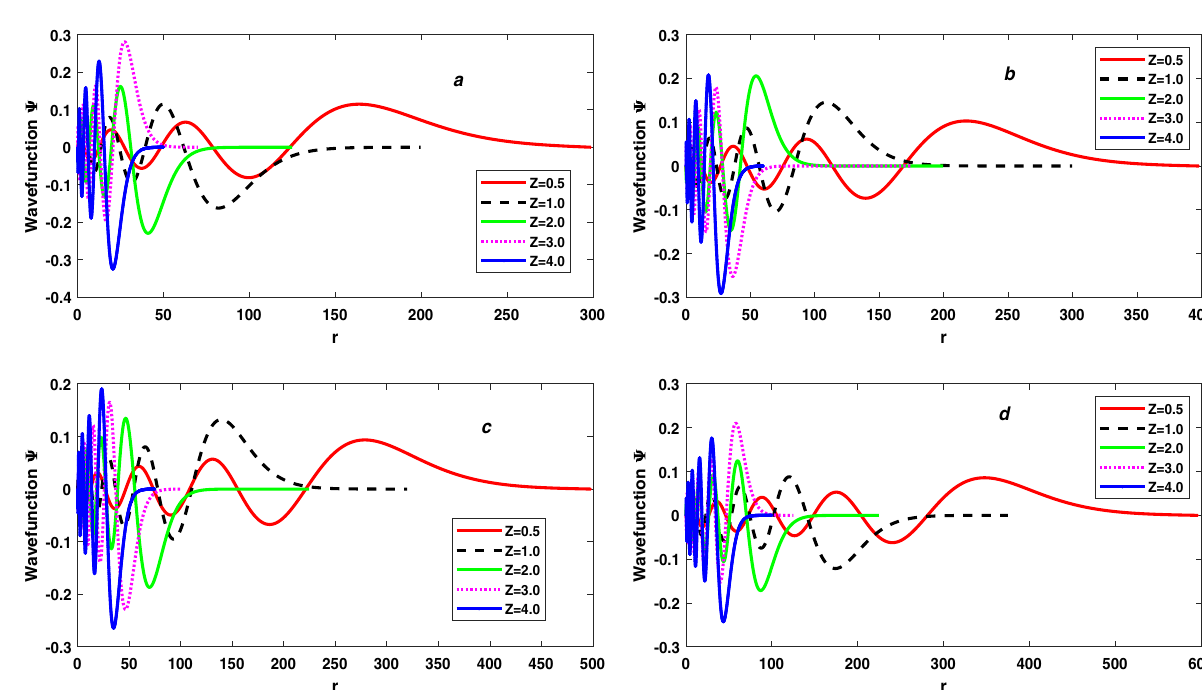
Figure 1. The variation of Wavefunction (cid:31) with r and atomic number Z for 7s state ( a ), 8s state ( b ), 9s state ( c ) and 10s state ( d ) of free Hydrogen-like